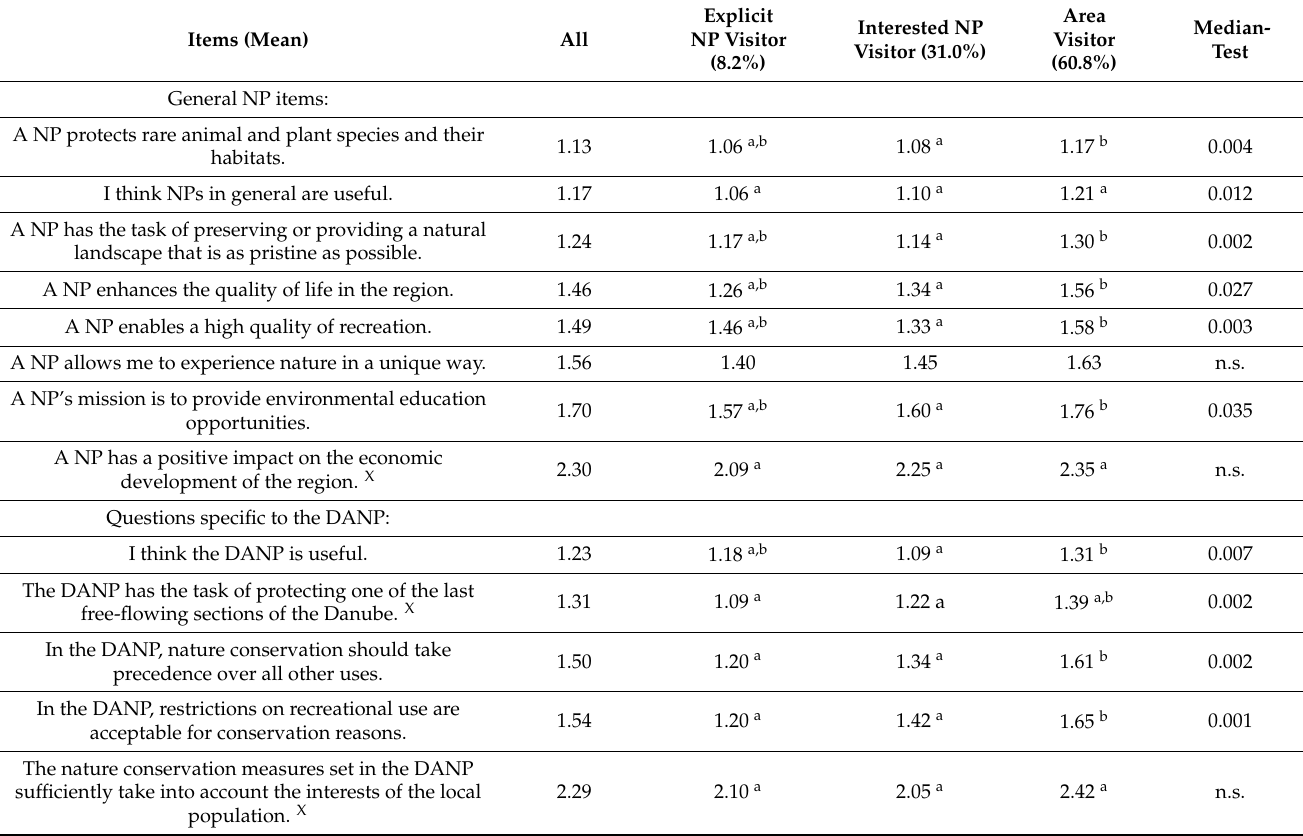
Table 4. Visitor segments’ attitudes towards NP and DANP (n = 423).